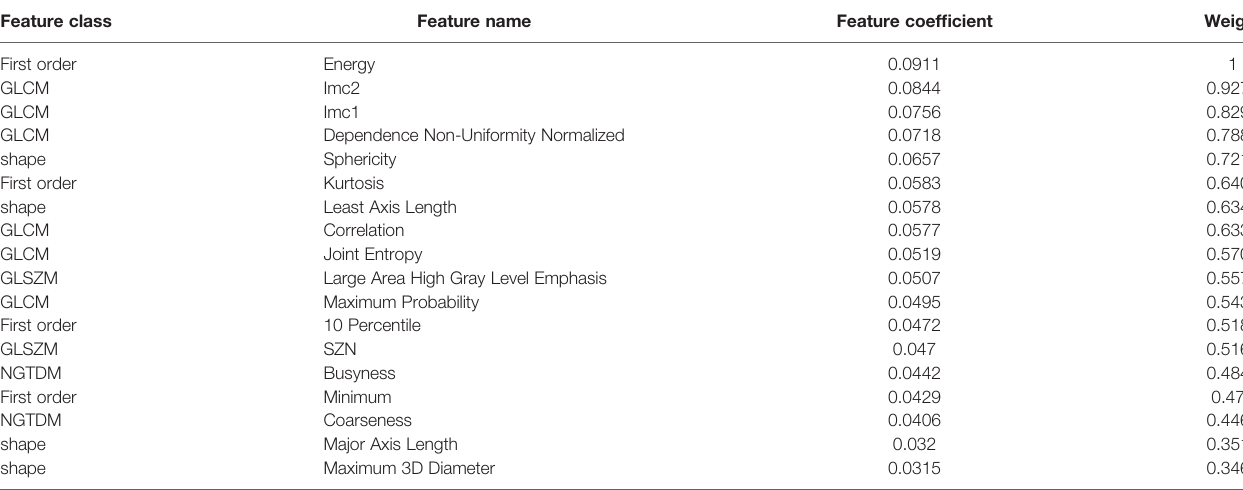
TABLE 4 | Selected radiomic features for the prediction model